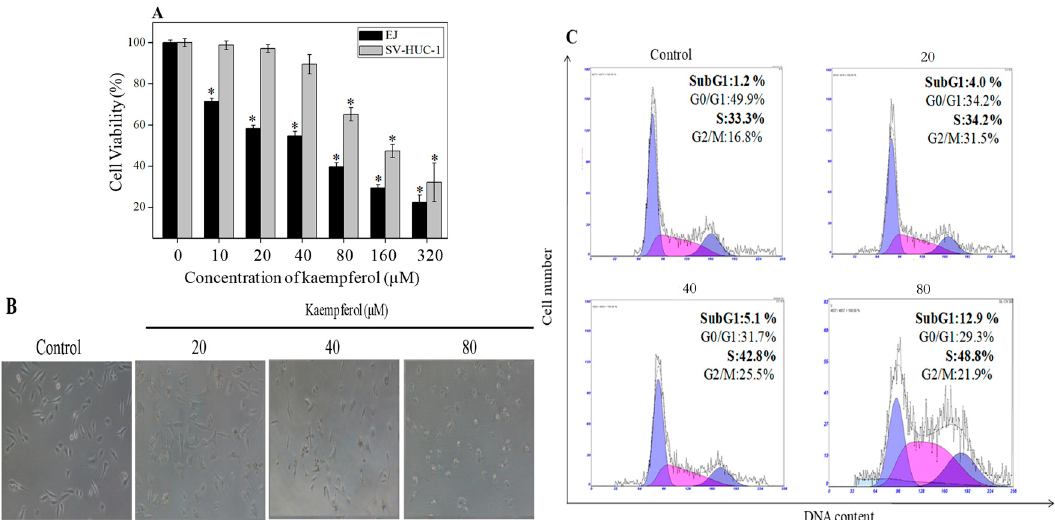
Figure 4. Protective effects of kaempferol on bladder cancer EJ cells. ( A ) The effects of kaempferol on the cell viability of an EJ cell and a normal bladder cell SV-HUC-1. ( B ) Morphological changes of EJ cells as examined by phase-contrast microscopy (magnification, 200 × ). ( C ) Kaempferol-induced S cell cycle arrest in EJ cells. Cell cycle distribution of EJ cells treated with kaempferol was analyzed by flow cytometric analysis. ∗ p < 0.05 versus the control.